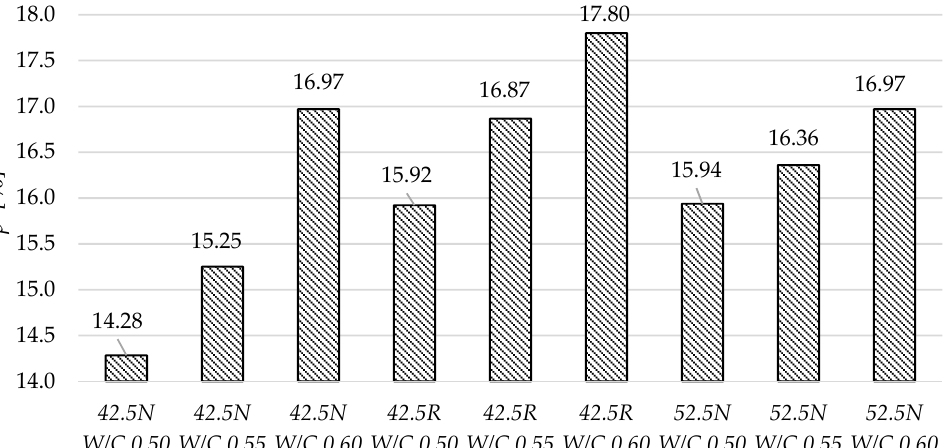
Figure 10. Cumulative distribution volume ( a ) and log ‐ differential pore distribution ( b ) graphs of the mortars based on CEM II A ‐ S 52.5N.